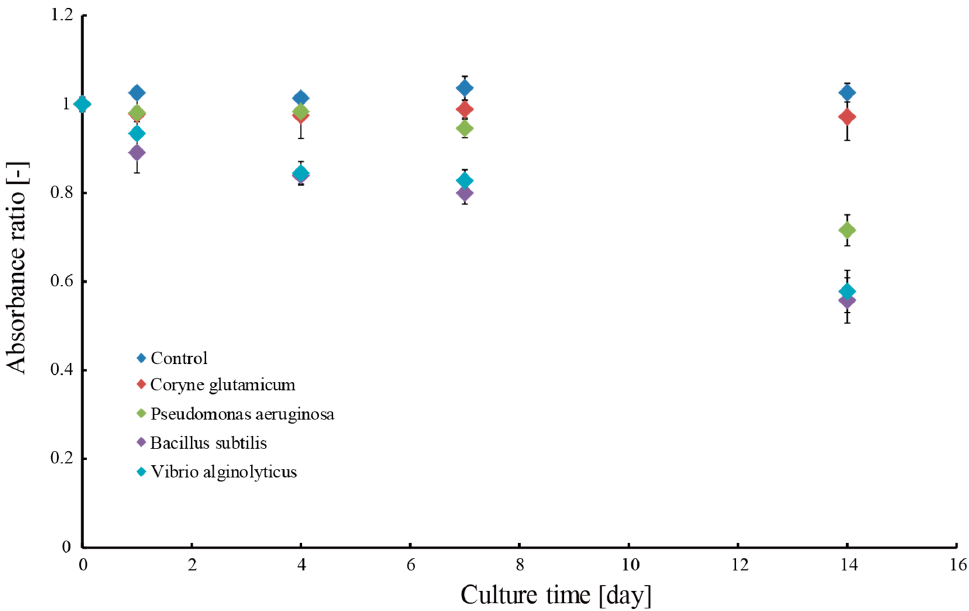
Figure 9. Relationship between absorbance ratio of methylene blue and culture time of each microbe.